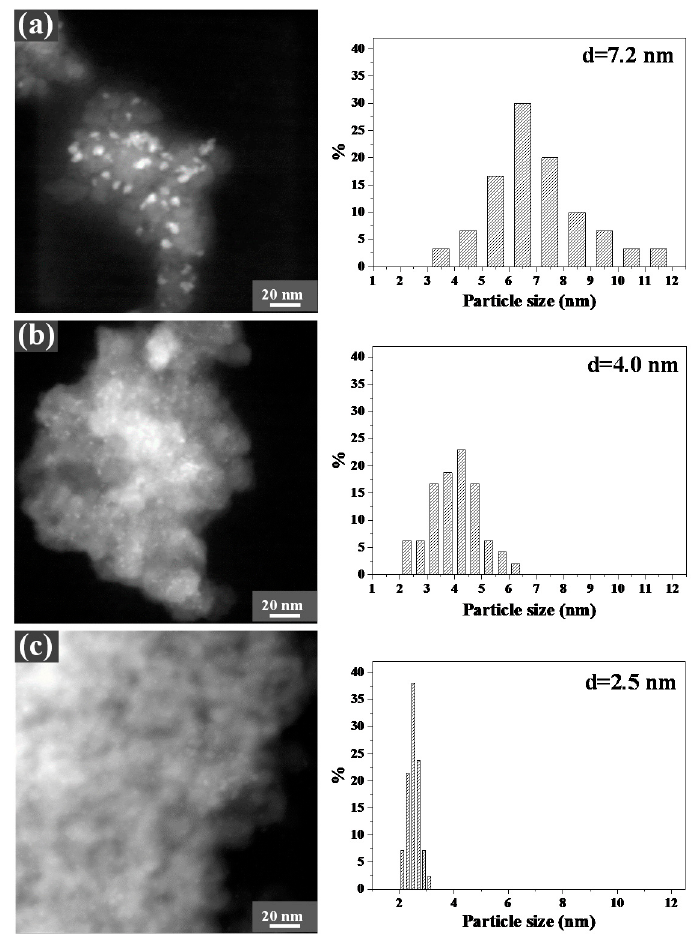
Figure 6. HAADF-STEM images and particle size distributions of Co over the reduced catalyst of Co/SiO 2 ( a ), Co-3gly/SiO 2 ( b ), and Co(3gly)/SiO 2 ( c ). Co / SiO 2 ( a ), Co-3gly / SiO 2 ( b ), and Co(3gly) / SiO 2 ( c